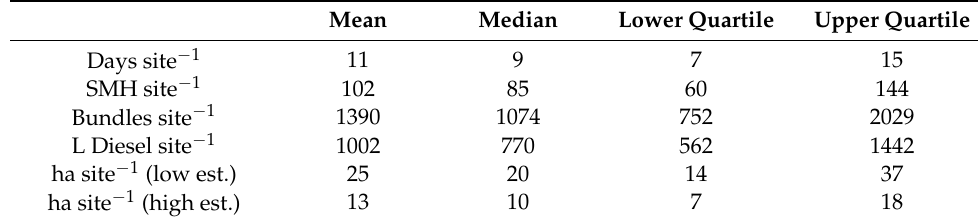
Table 6. Worksite statistics ( n =